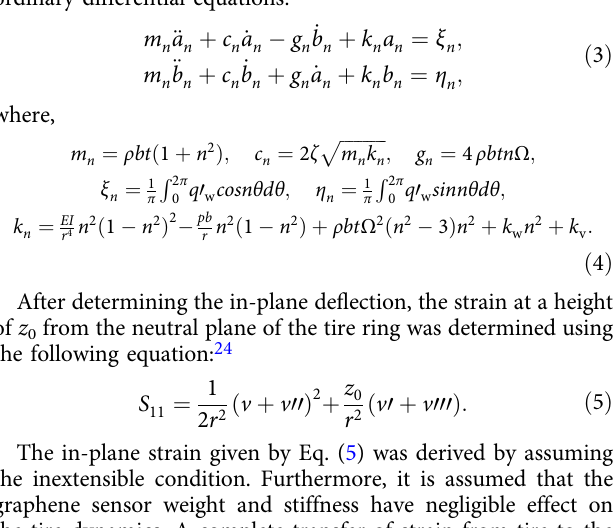
in tire pressure or with the increase in the tire normal